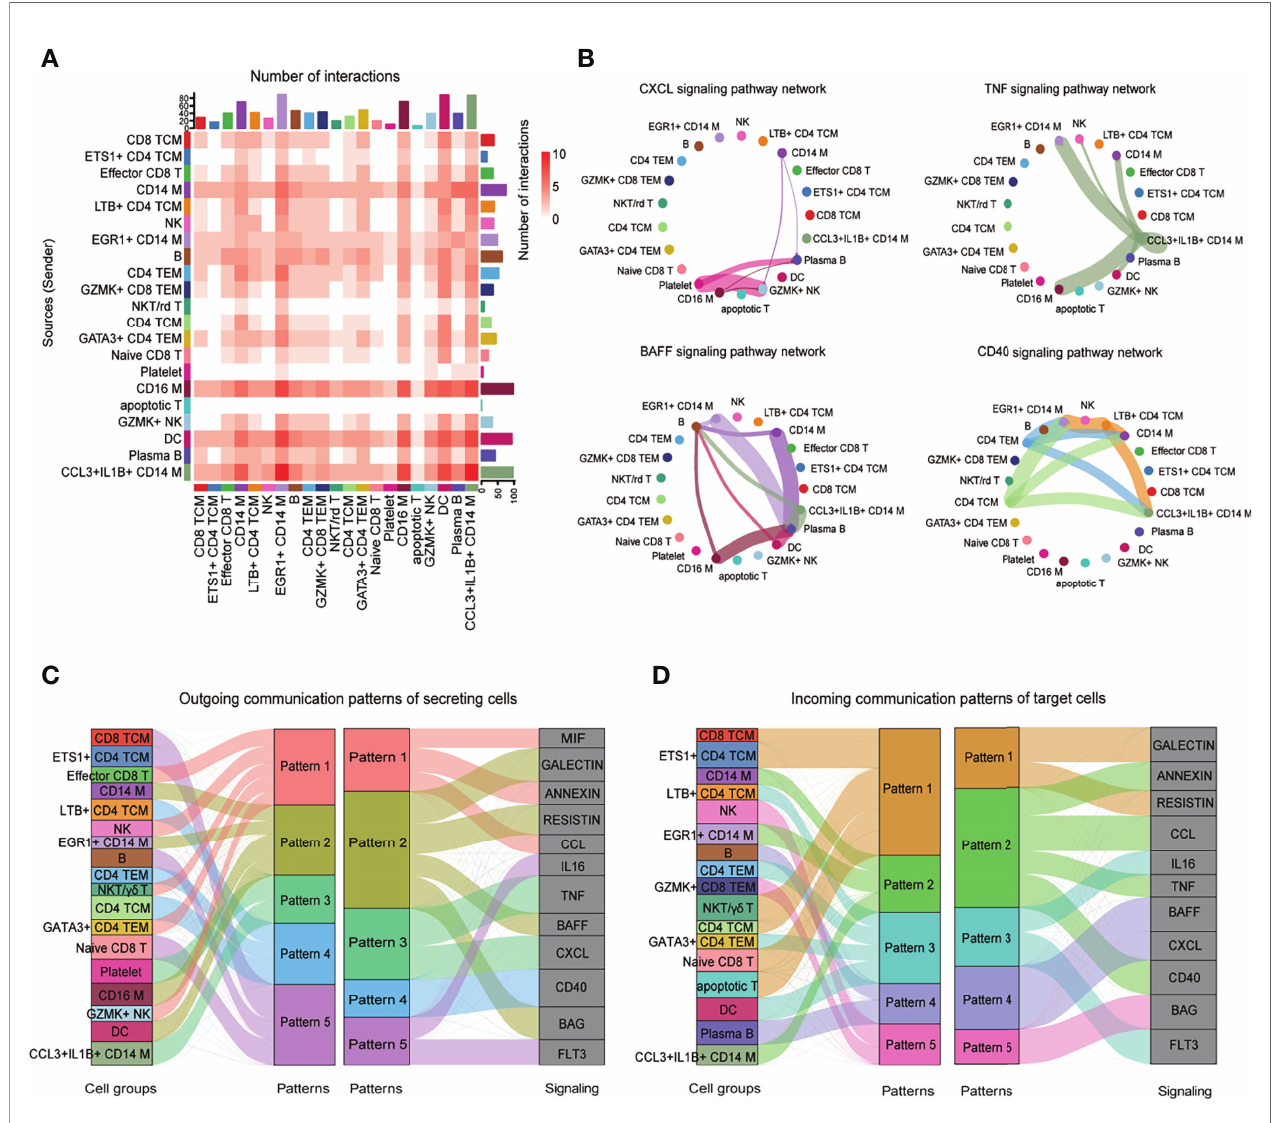
FIGURE 7 | CellChat analysis of the communications among immune cells. (A) Heatmap showing the number of interactions of different cell subsets in PBMCs. (B) Circle plot showing the inferred intercellular communication network for CXCL, TNF, BAFF, and CD40 signaling among different cell subsets. The number of cells in each cluster is proportional to the circle size, and the line thickness represents the strength of signaling. (C) The inferred outgoing communication patterns of secreting cells, which shows the correspondence between the inferred latent patterns and cell groups, and signaling pathways. The thickness of the fl ow indicates the contribution of the cell group or signaling pathway to each latent pattern. (D) The inferred incoming communication patterns of target